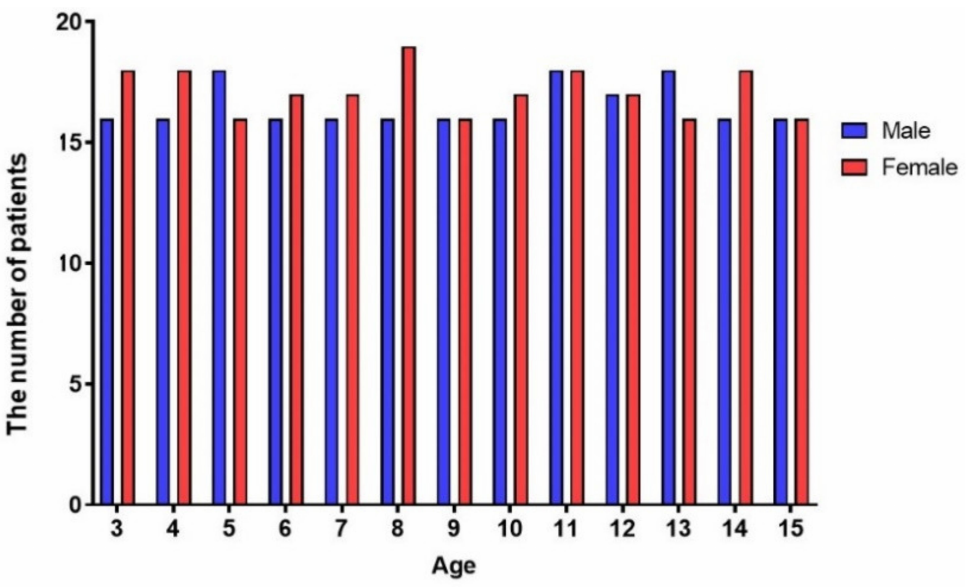
Figure 1. Distribution of participants according to sex and